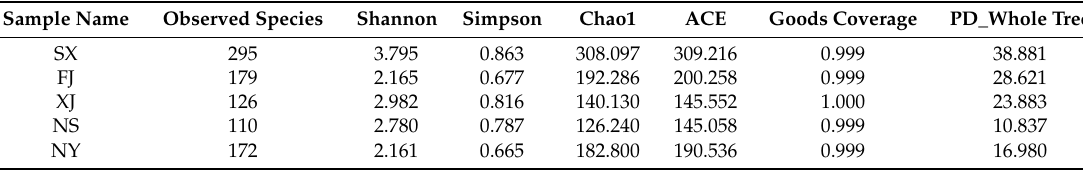
Table 3. Median alpha diversity indices.